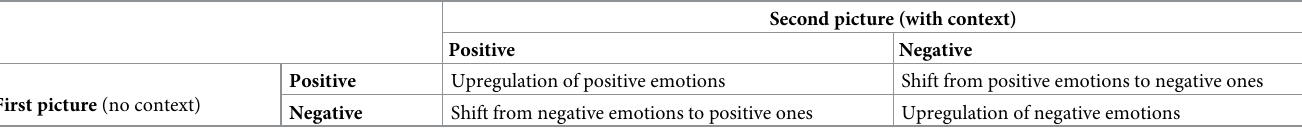
Table 1. Understanding emotional flexibility in terms of context-driven emotional